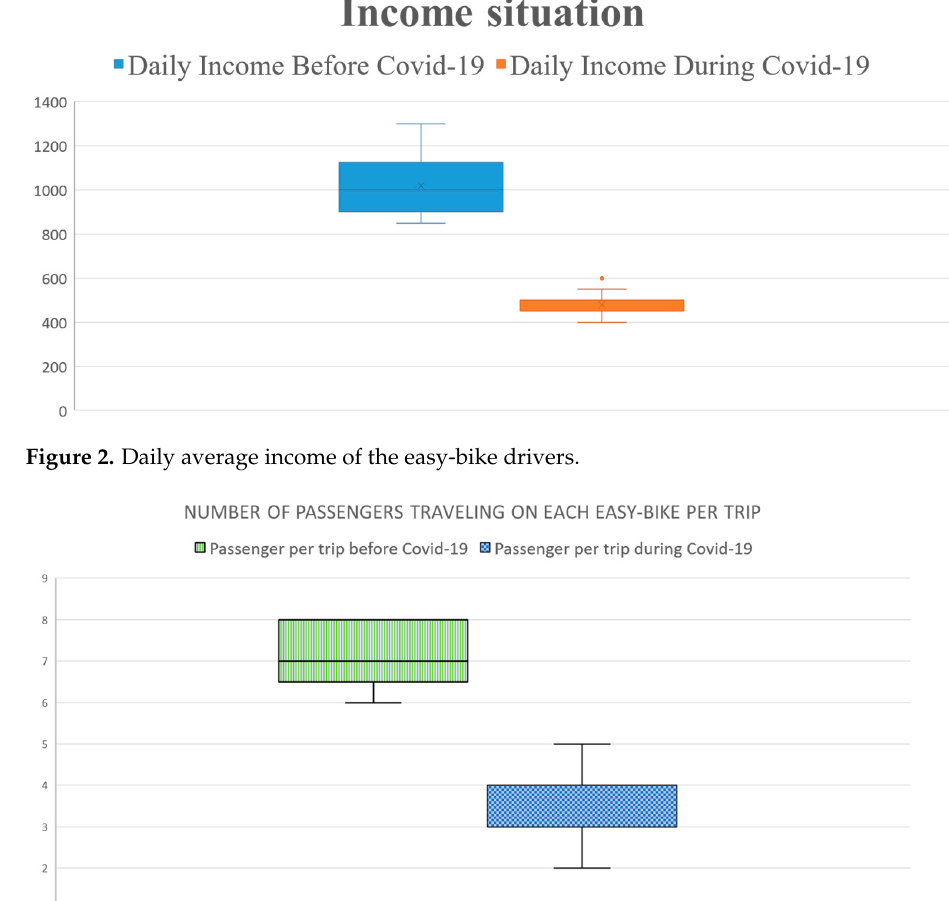
Figure 2. Daily average income of the easy-bike drivers.